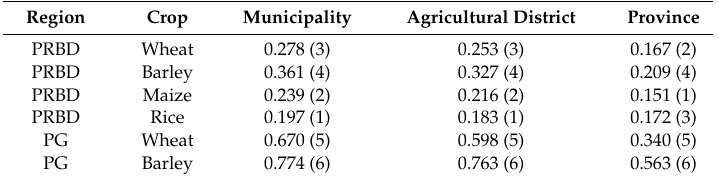
Table 4. Average, mean-adjusted RMSE across all model specifications for the three spatial aggregation scale considered: municipality, agricultural district and province. A rank of the best predictable species at each administrative level is provided between